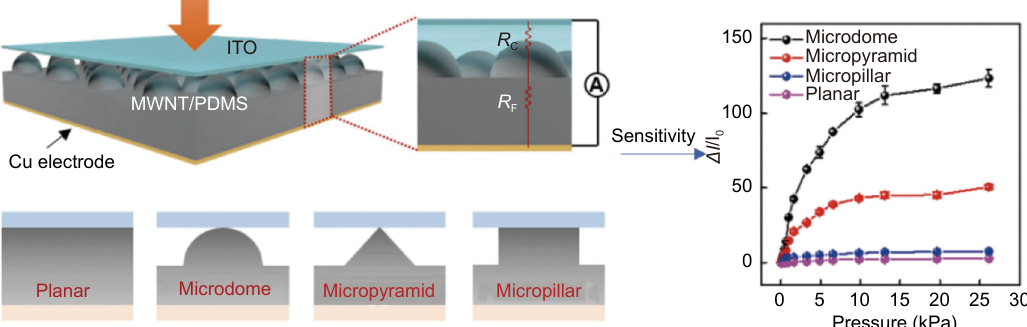
Fig. 5 | Sensitivities of different microstructure sensors. ITO, indium tin oxide; MWNT, multiwalled carbon nanotubes; and PDMS, polydi- methylsiloxane. Figure reproduced with permission from ref. 94 , under a Creative Commons Attribution 4.0 International